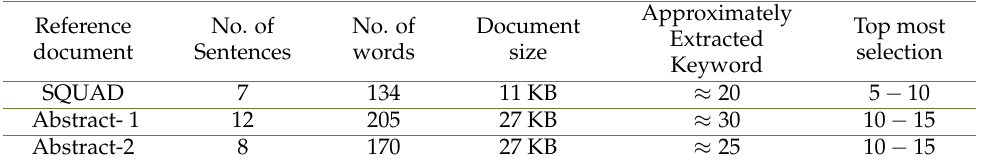
Table 2. Input Document.